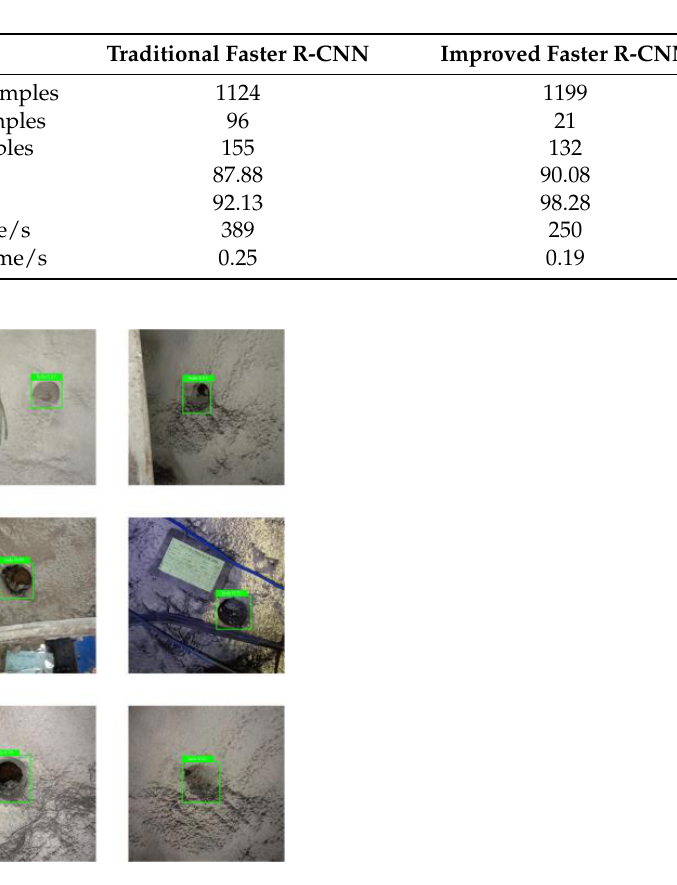
Figure 17. Recognition result graph of underground pressure relief holes based on improved Faster R-CNN model. Table 6. Relief hole target recognition results based on the improved SqueezeNet + BN model with different measures.